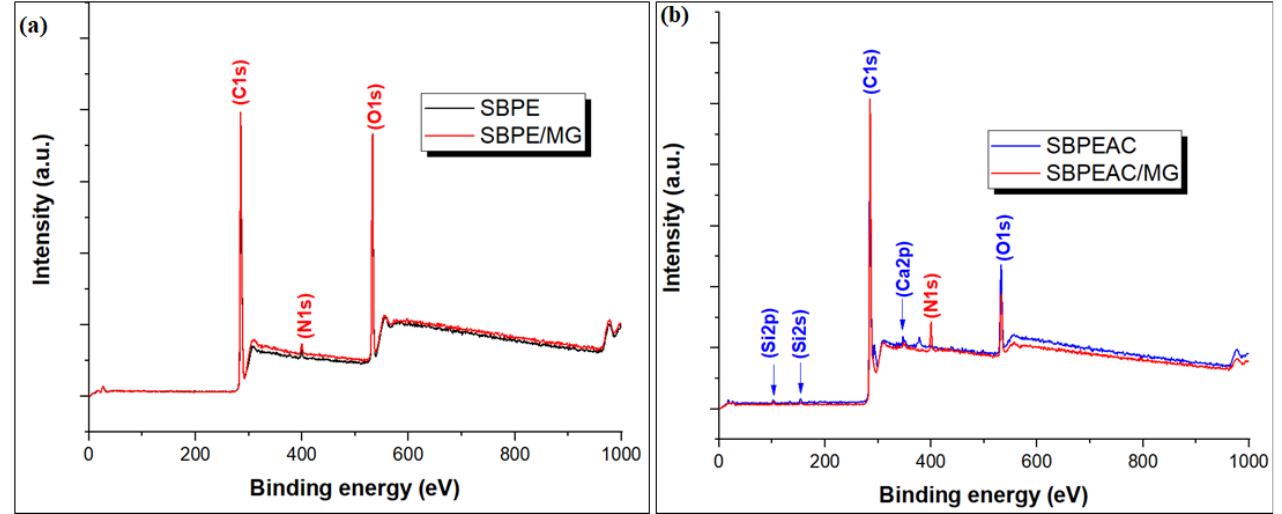
Figure 2. Full scan XPS survey spectra of pristine and MG saturated SBPE ( a ) and SBPEAC compo- sites ( b ).